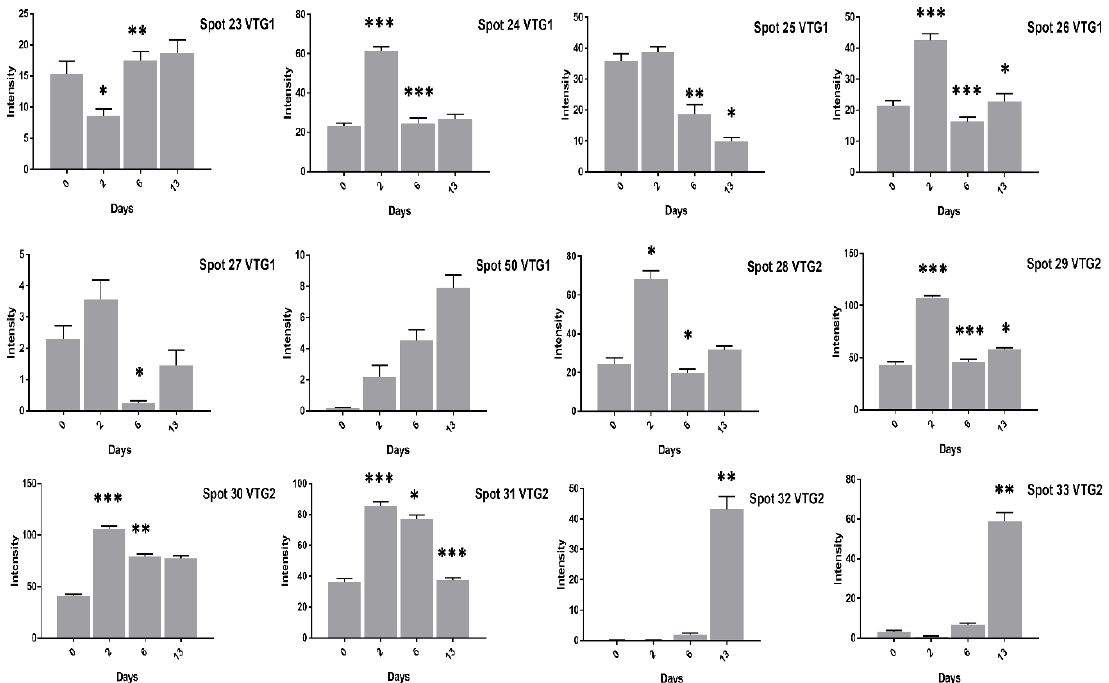
Figure 5. The VTG1 and VTG2 proteins spots expression at 0, 2, 6, and 13 days of incubation are shown in low cholesterol eggs. The column profiles of VTG1 (23–27, 50) and VTG2 (28–33) are shown as bar charts with significant differences. The error bars represent the standard deviation. * p < 0.05, ** p < 0.005, *** p < 0.0001.